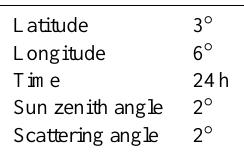
Table 1. Coincidence criteria for the GOMOS and OSIRIS radiance